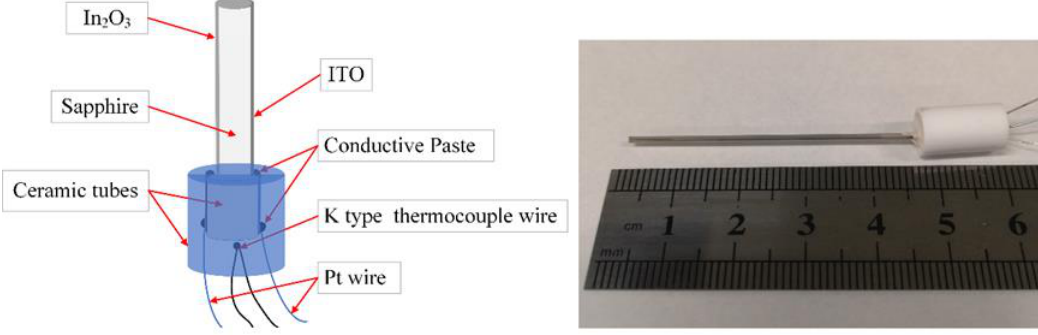
Figure 2. ( a ) Schematic of the ITO thin-film thermocouple probe and ( b ) the fabricated sensor.